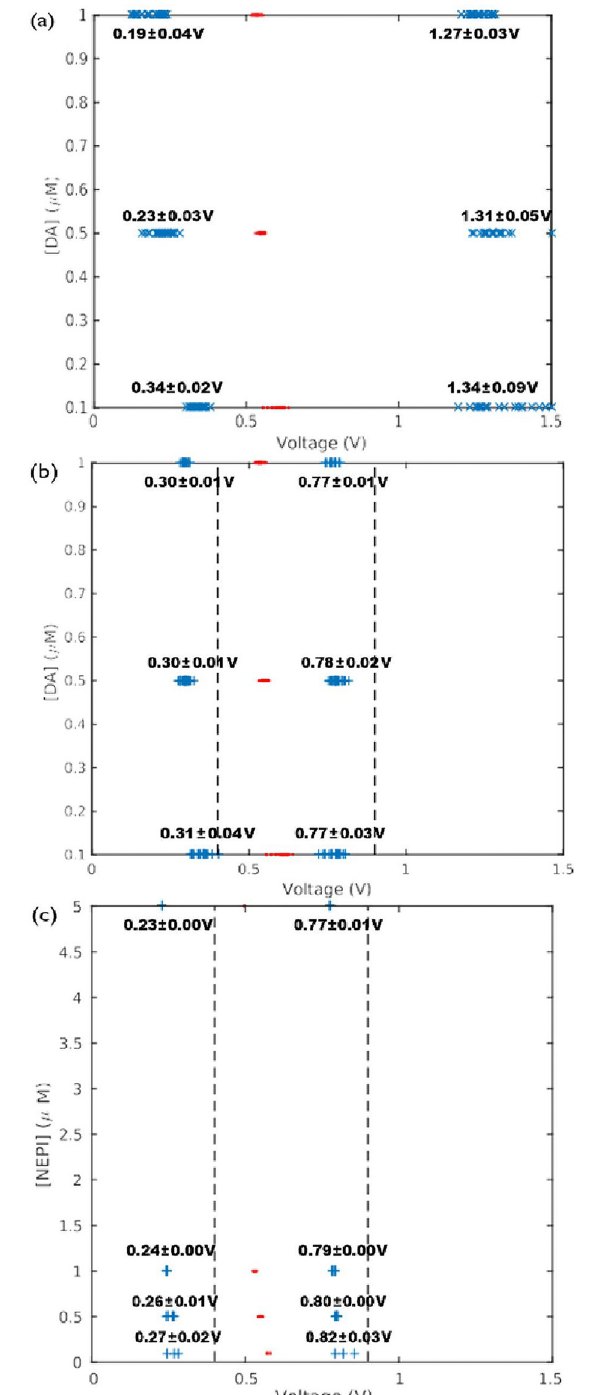
Fig 2. a) True integration limits (“x”) and maximum oxidation currents (dots) obtained from a flow cell experiment consisting of 70 dopamine injections at different concentrations. b) Curvature integration boundaries (“+”) for the experimental data of (a). c) Curvature boundaries for a flow cell experiment with 15 norepinephrine injections at different concentrations. FSCAV limits are shown with dashed vertical lines. Quantities shown in the figure indicate averages ± standard